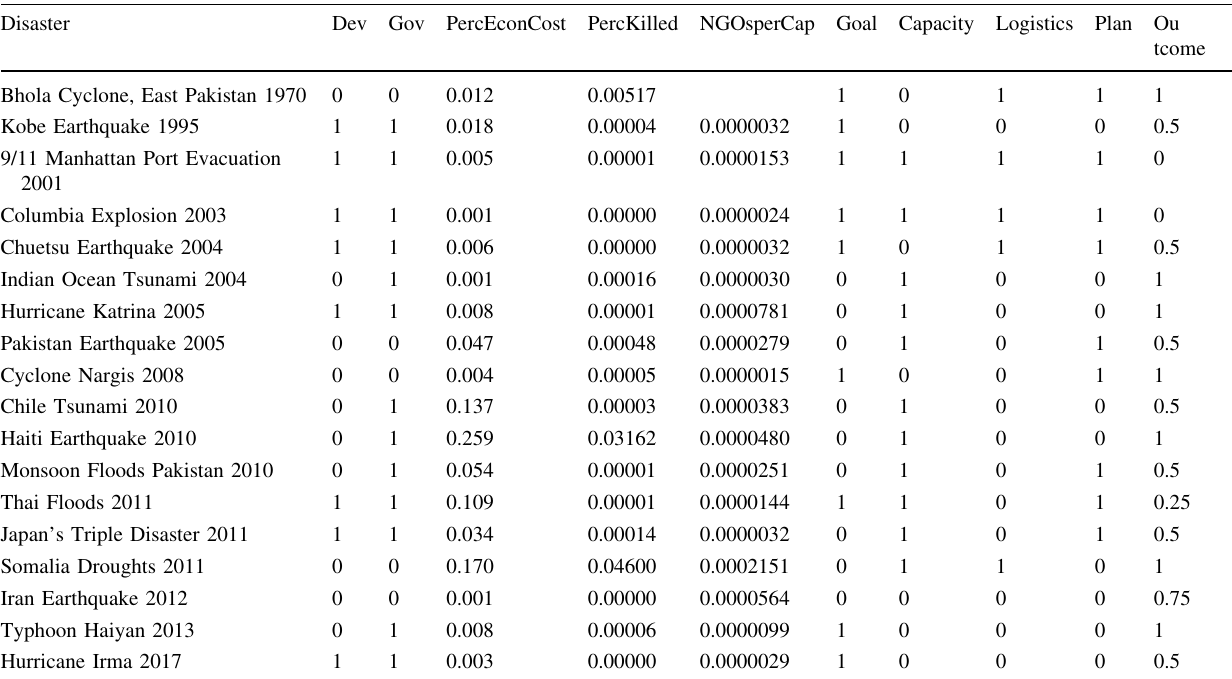
Table 3 Truth table for the disaster responses to nine interacting variables in 18 disaster events in the Americas, Asia, and East